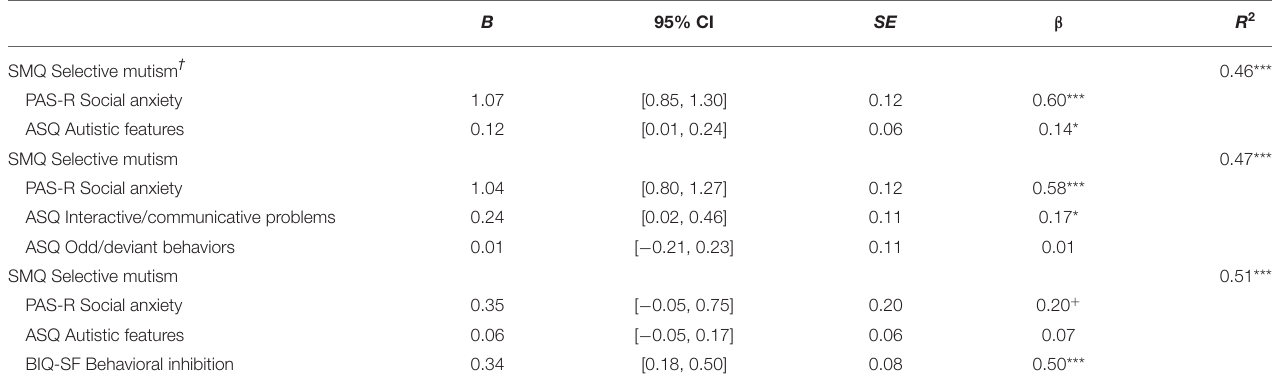
TABLE 2 | Main results of the regression analyses in which symptoms of SM were predicted from social anxiety, autistic features, and behavioral